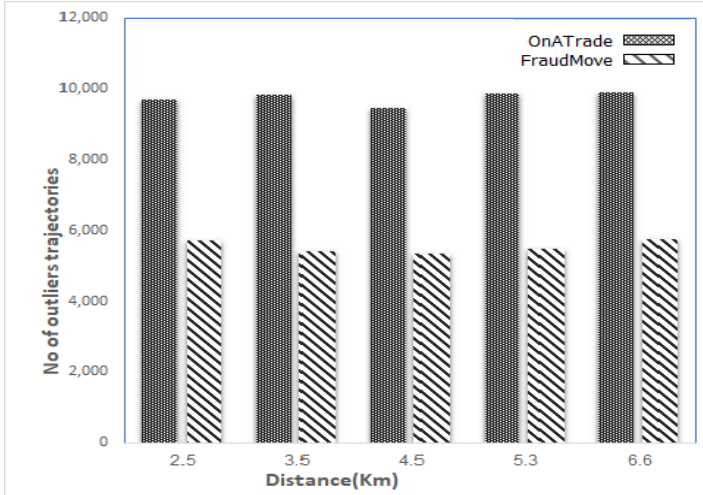
Figure 14. Comparing FraudMove to OnATrade